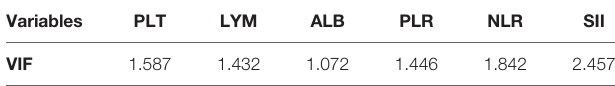
TABLE 3 | VIF of in fl ammation-related factors in external application cohorts.